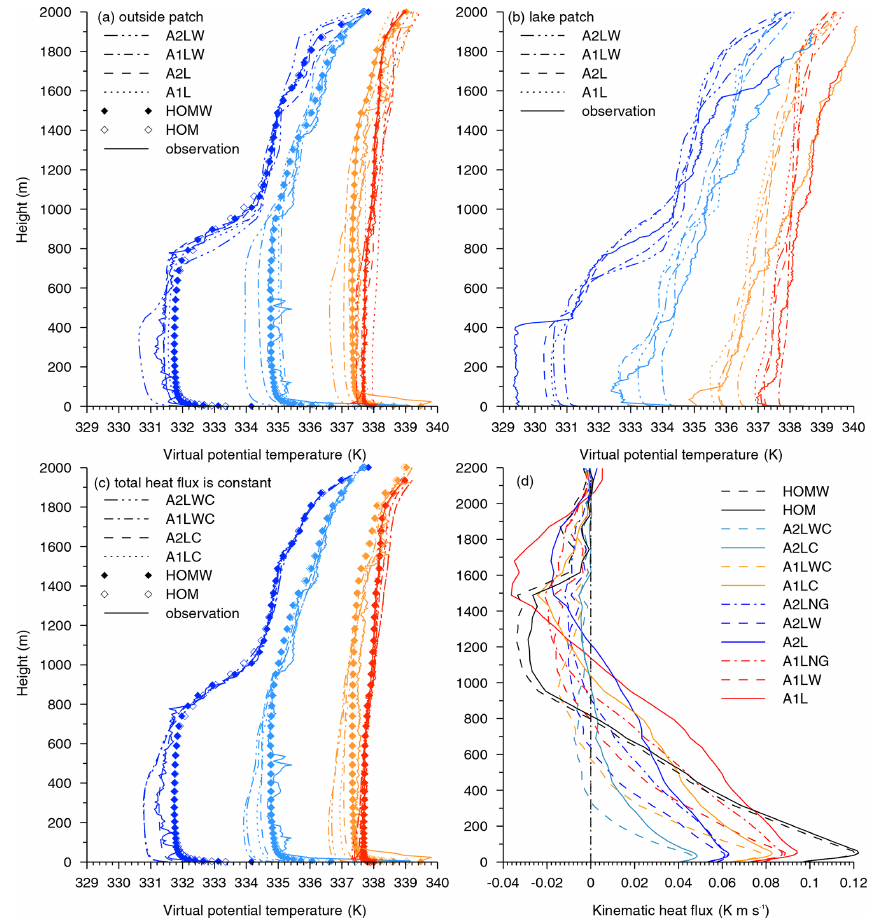
Figure 4. The profile of the horizontal, averaged virtual potential temperature for the observations and all of the runs over the lake patches (a) and outside of the lake patches (b) . Panel (c) is the same as (a) except for heterogeneous and homogeneous runs with constant surface heat flux. Legends for (a–c) dark and light blue represent the results at 09:30 and 12:30LT, respectively, and the orange and red lines show the results at 15:30 and 18:30LT, respectively. (d) The kinematic heat flux for all of the runs.